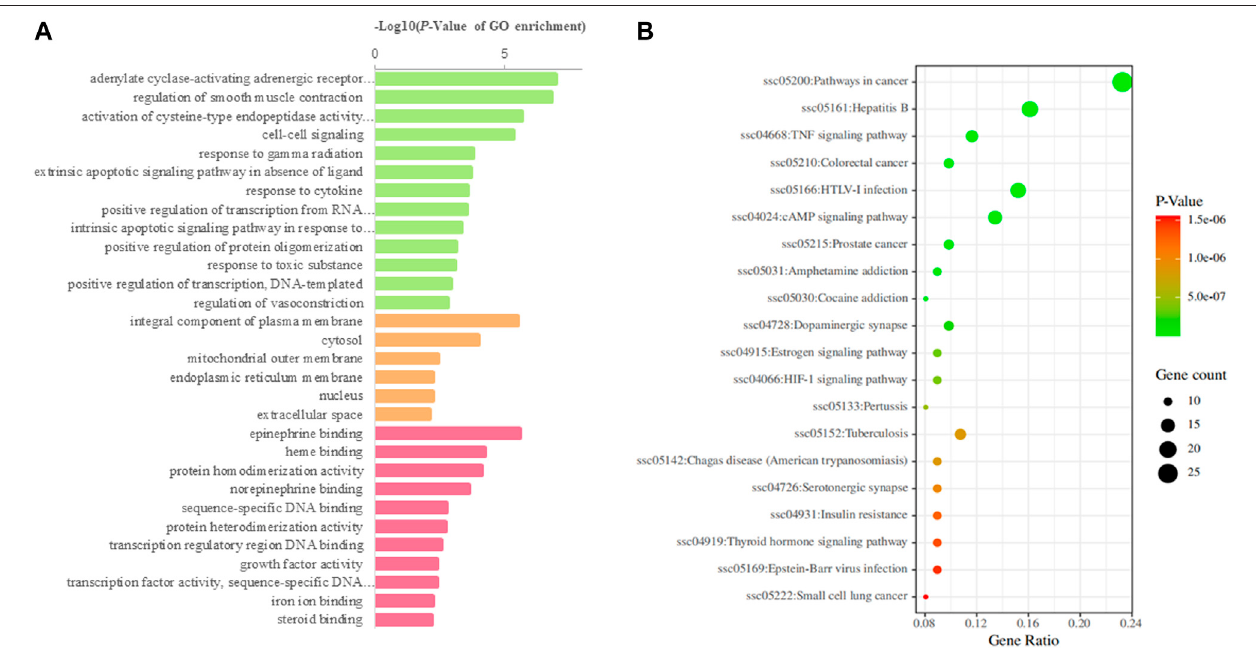
FIGURE 4 | GO and KEGG analysis of the candidate targets. (A) Biological process enrichment of candidate targets. (B) KEGG pathwayenrichment of candidate targets.